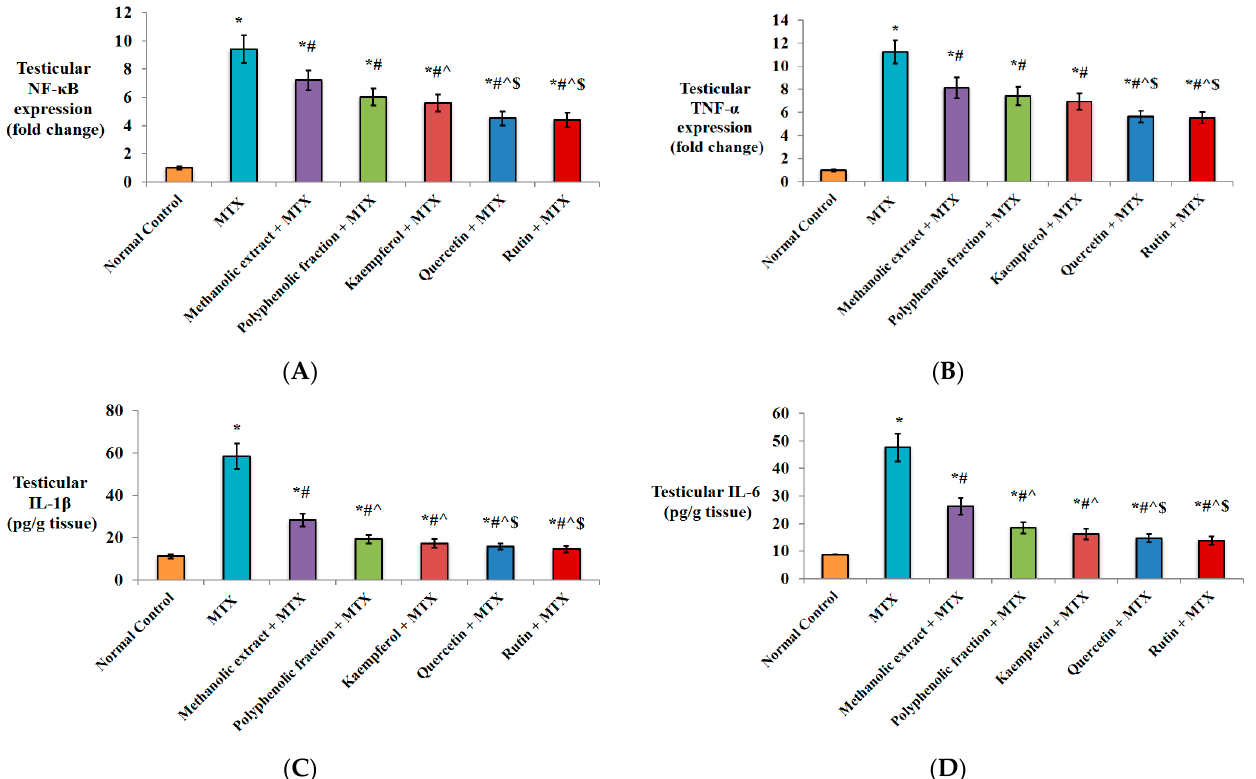
Figure 2. Effect of M. alysson L. methanolic extract, its polyphenolic fraction, kaempferol, quercetin and rutin on testicular injury-induced mice. ( A ) Testicular NF- κ B mRNA expression, ( B ) Testicular TNF- α mRNA expression, ( C ) Testicular IL-1 β level and ( D ) Testicular IL-6 level. Data are presented as mean ± SD, (n = 8). * Significant versus normal control. # Significant versus MTX. ^ Significant versus methanolic extract. $ Significant versus polyphenolic fraction. p value ≤ 0.01.